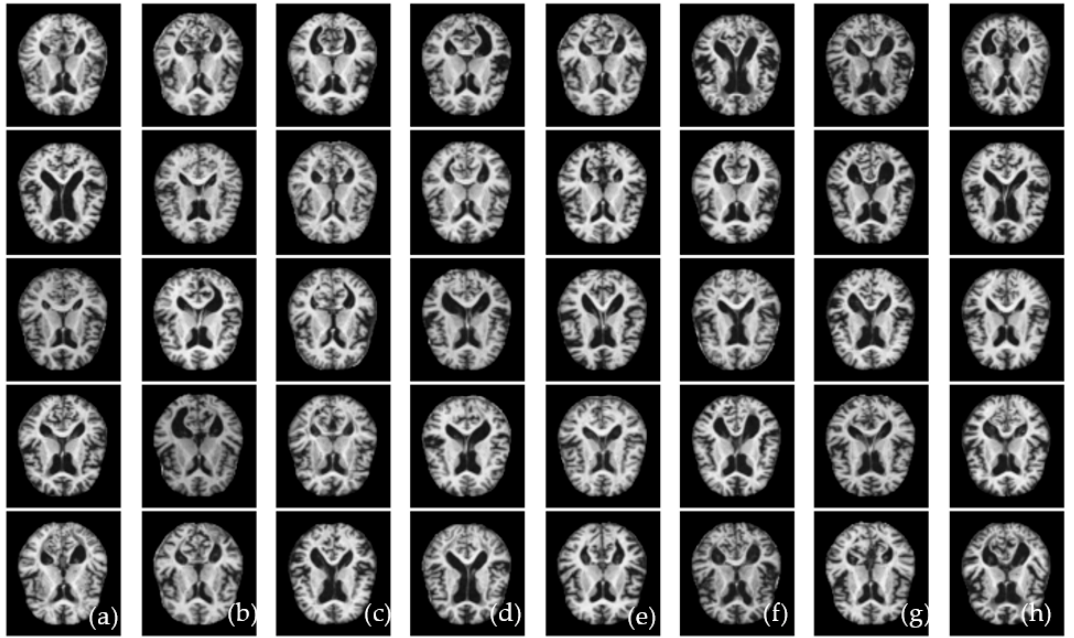
Figure 10. A visual example of classification of CAD-ALZ system for recognition of AD disease on Kaggle-ALZ ( a – h ), where figure shows normal ( a , e ), mild dementia ( b , f ), moderate dementia ( c , g ), and very mild dementia ( d , h ).